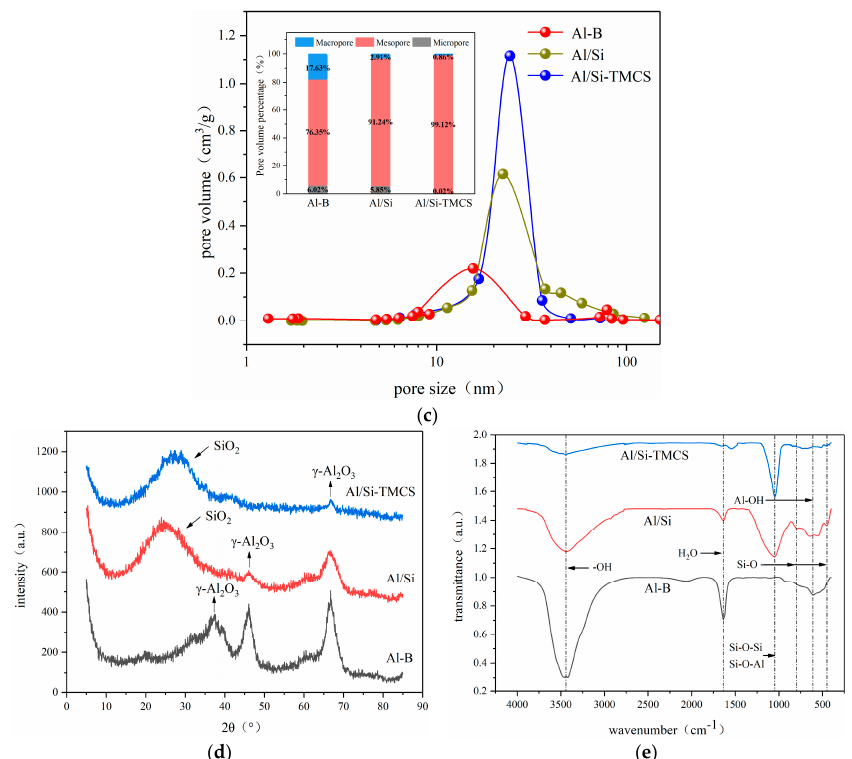
Figure 3. Characterization results of Al 2 O 3 aerogels. ( a ) macroscopic and microscopic surface structures of three types of Al aerogels; ( b ) N 2 adsorption-desorption curves of three types of Al aerogels; ( c ) Pore size distributions of three types of Al aerogels; ( d ) X-ray diffraction (XRD) spectra of three types of Al aerogels; ( e ) Fourier transform infrared (FT-IR) spectra of three types of Al aerogels.